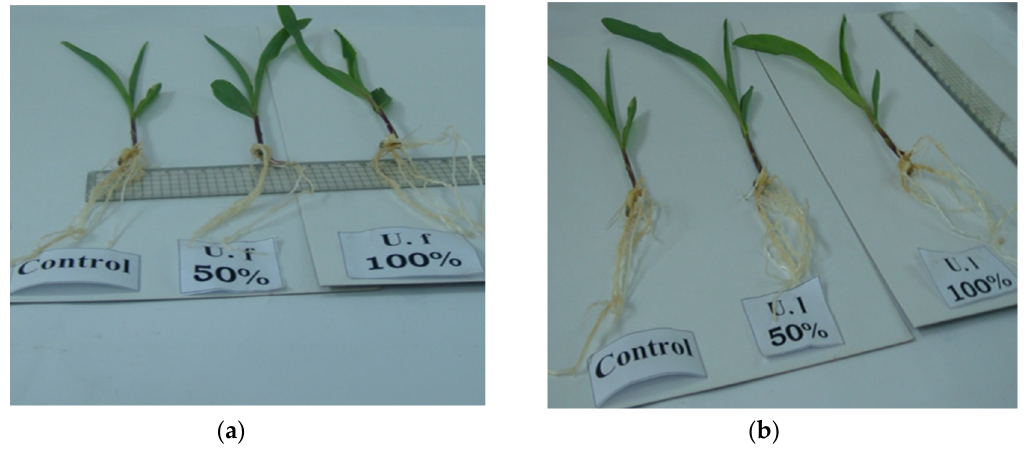
Figure 3. ( a ) Zea mays growing seedlings (U.f 50%: U.f. polysacch.5mg/mL, U.f 100%: U.f. polysacch. 10 mg/mL), ( b ) Zea mays growing seedlings (U.l 50%: U.l. polysacch. 5 mg/mL, U.l 100%: U.l. polysacch. 10